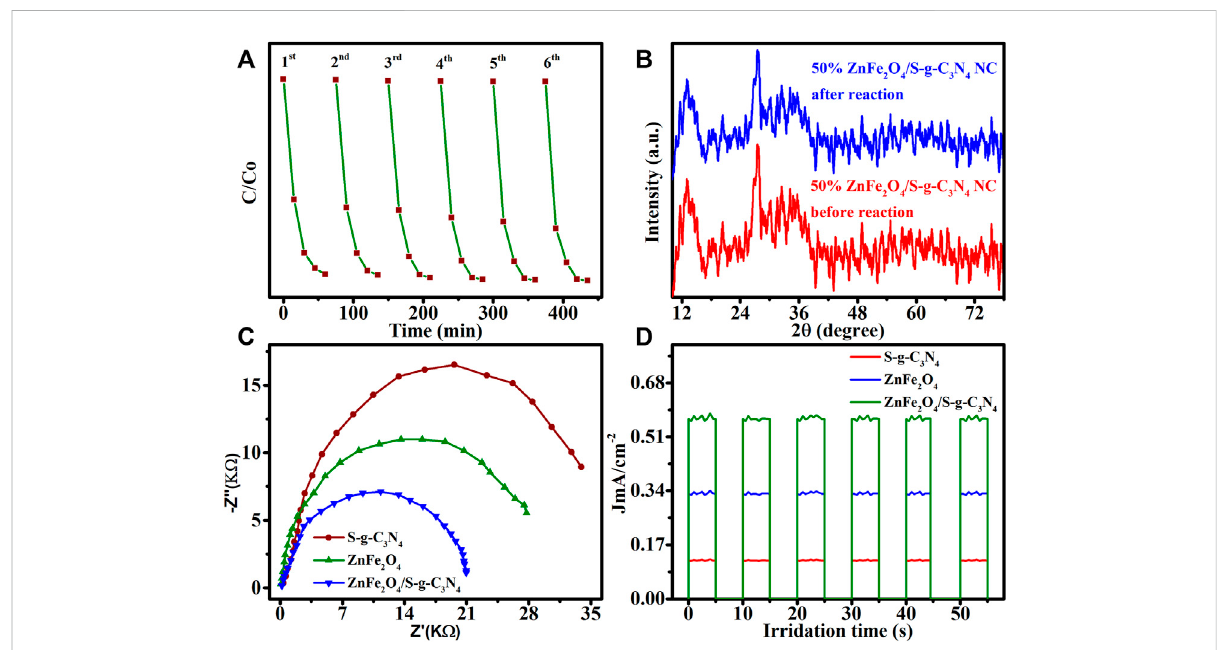
FIGURE 6 (A) Cyclic stability of 50% ZnFe2O4/S − g-C3N4 NCs photocatalyst for 6 sequential MB photodegradation tests. (B) Structural stability of 50% ZnFe2O4/S-g-C3N4 NCsidenti fi edbyXRDpatternsrecordedbeforethe fi rstcycleandafterthesix-recyclingtest. (C) EISNyquistplotsofS-g-C 3 N 4 , ZnFe2O4 and 50% ZnFe2O4/S-g-C3N4 NCs. (D) Transient photocurrent responses of undoped S-g-C 3 N 4 , ZnFe2O4 and 50% ZnFe2O4/ S-g-C3N4 NCs in visible-light irradiation ( λ > 420